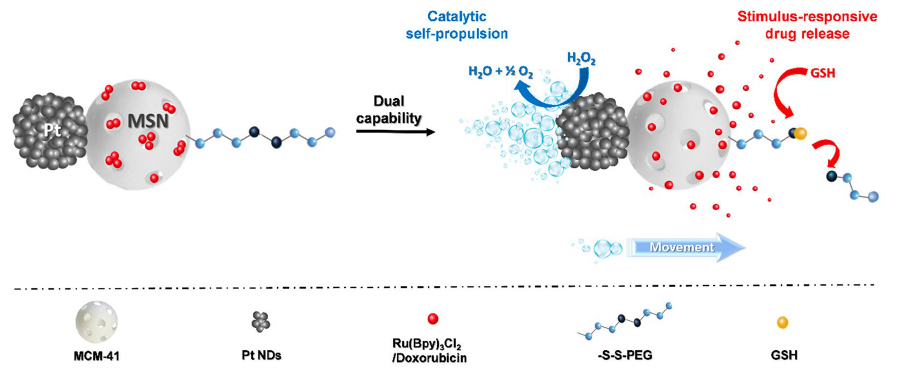
Figure 4. Scheme of Janus Pt-MSNs nanomotors with a catalytic self-propulsion for drug delivery by the catalytic reduction of H 2 O 2 mediated by glutathione [52]. Copyright © Authors of the publication (open access).